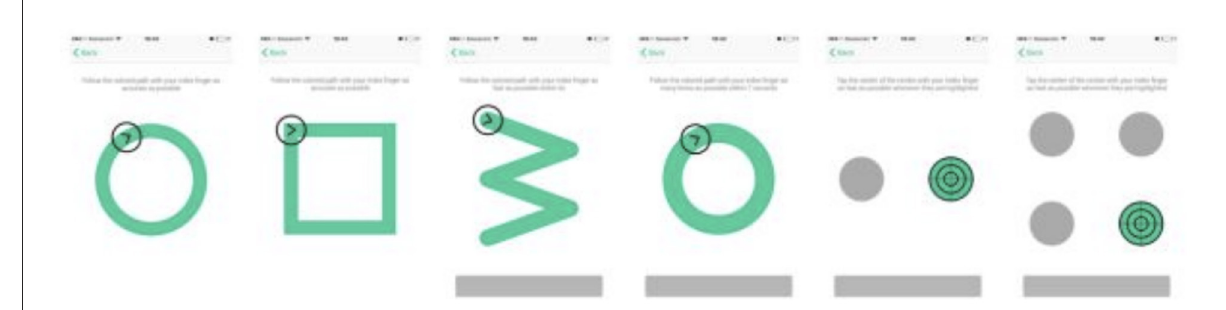
FIGURE2 The motoric functioning tasks in the Altoida DNS test. These are executed one after another. Using their index finger of their dominant hand, from left to right, the task is to (1) draw a circle, (2) draw a square, (3) draw a rotated W shape within 7s, (4) draw as many circles as possible within 7s, (5) tap the highlighted buttons (left, right, left, right, etc.) (6) tap the highlighted button as fast as possible, the buttons highlight at random.